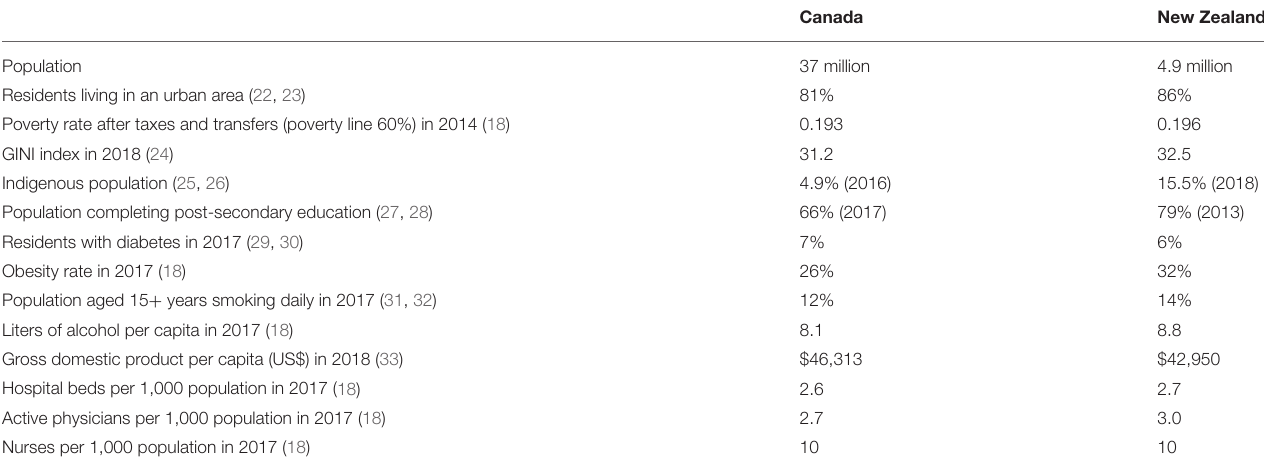
TABLE 1 | Comparison of relevant characteristics of the Canadian and New Zealand